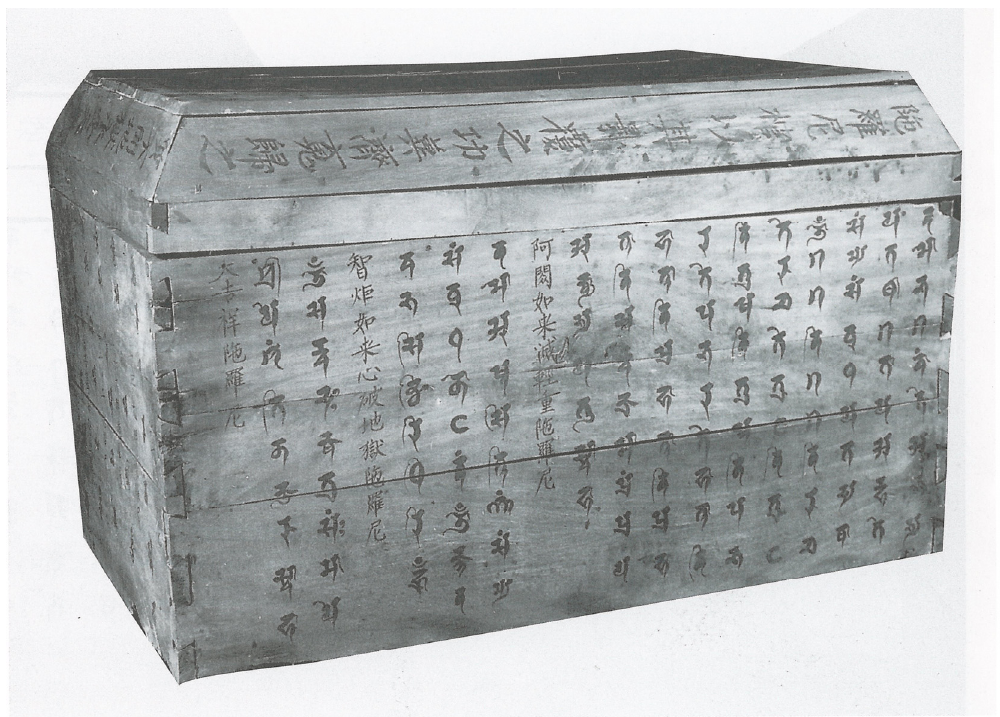
Figure 5. Wooden coffin inscribed with Buddhist incantations. Liao dynasty, dated 1093. H. 59.8 cm.